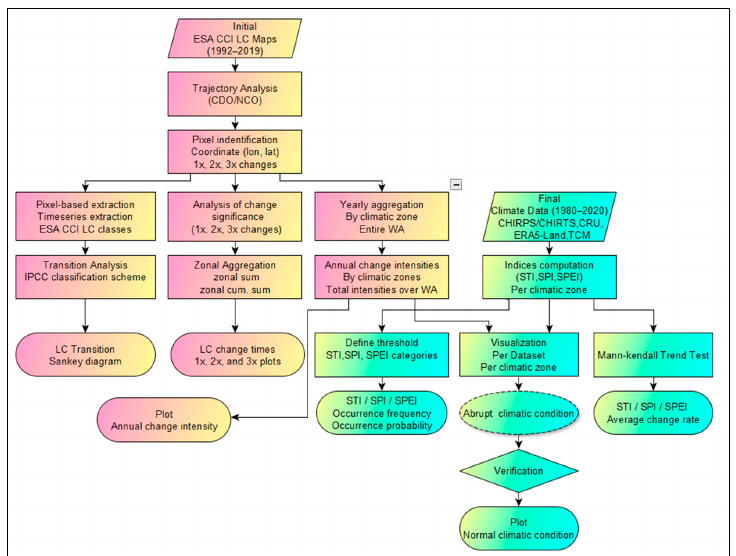
Figure 2. Overall steps used to assess the interaction between land cover changes and climatic changes.